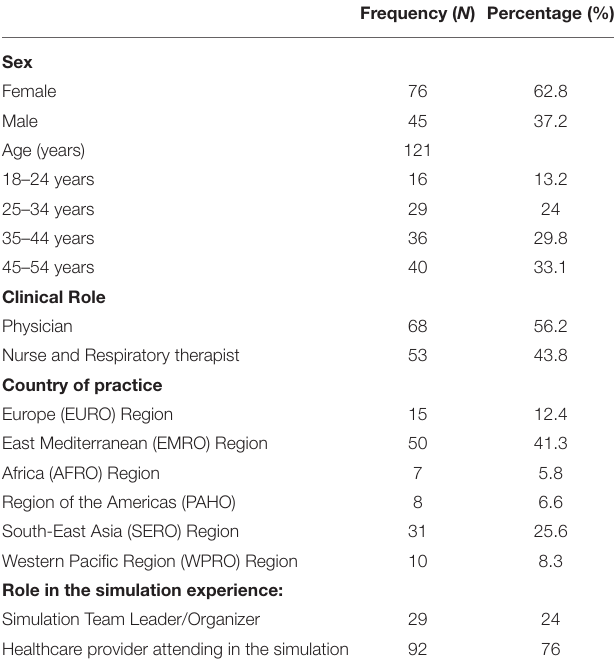
TABLE 1 | Descriptive analysis of participants’ sociodemographic and professional